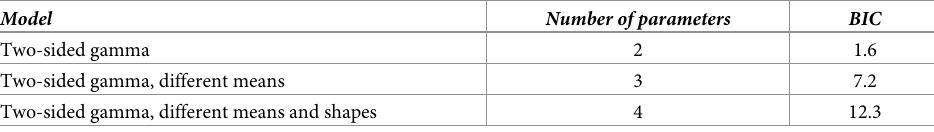
Table 3. Models, their numbers of parameters related to the DFE and BIC values. Model Two-sided gamma Two-sided gamma, different means Two-sided gamma, different means and